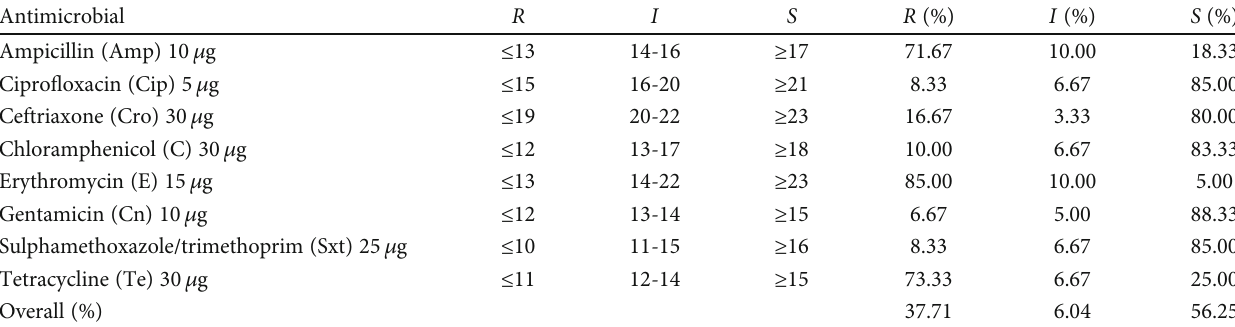
Table 2: Percentage antibiotic resistance of Escherichia coli isolated from meat samples in Tamale metropolis. Antimicrobial